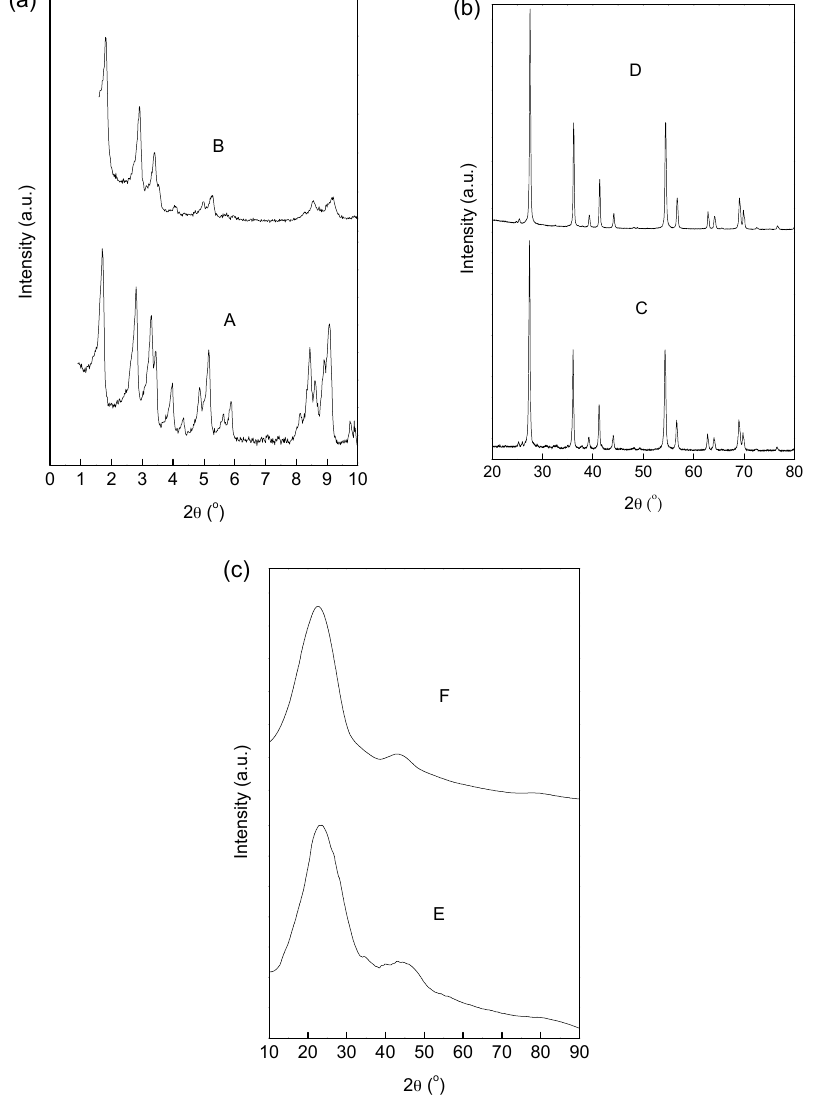
Figure 9. ( a ) XRD patterns of fresh (A) and recycled (B) CuNi/MIL-101; ( b ) XRD patterns of fresh (C) and recycled (D) CuNi/TiO 2 ; ( c ) XRD patterns of fresh (E) and recycled (F) CuNi/MIL-101 .